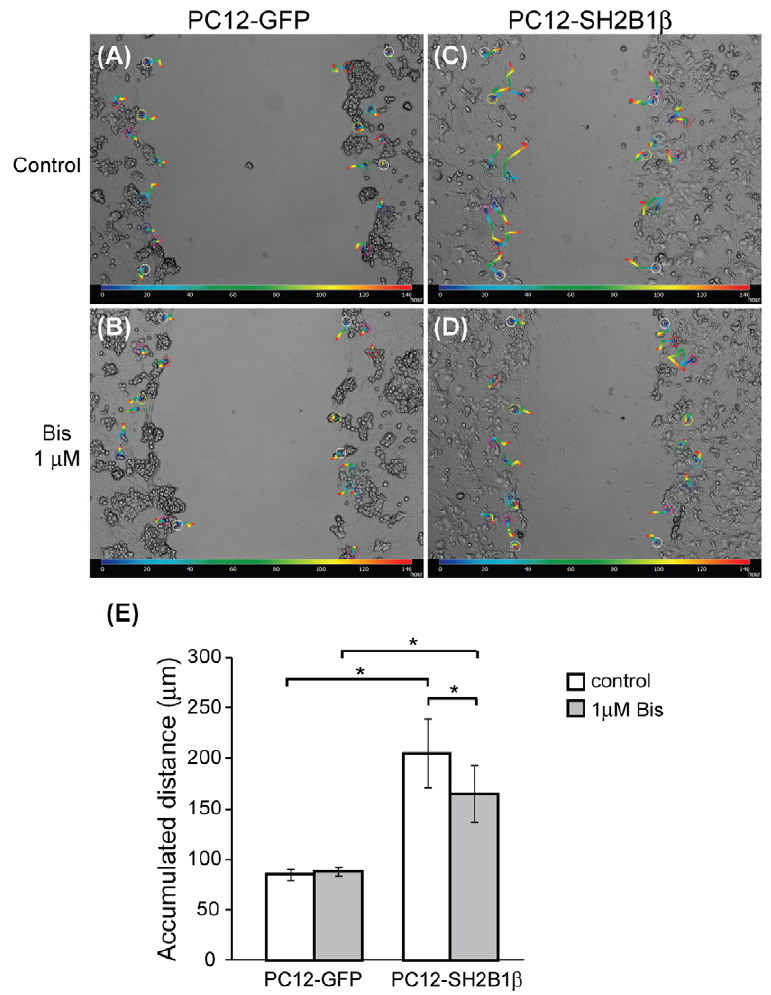
Figure 6. Inhibiting PKC activity decreases cell migration in PC12-SH2B1 b cells. PC12-GFP and PC12-SH2B1 b cells were differentiated as in Figure 1. On day 8, differentiated cells were pre-treated with or without 1 m M Bis for 1 h before wounding. (A–D) Migration paths were tracked from healing time 0 (blue) to 144 h (red) by tracking software. (E) Accumulated distance during healing days 0–6 for these cells were determined and shown. Values are mean 6 S.E.M. from three independent experiments. (*: P , 0.05, paired Student’s